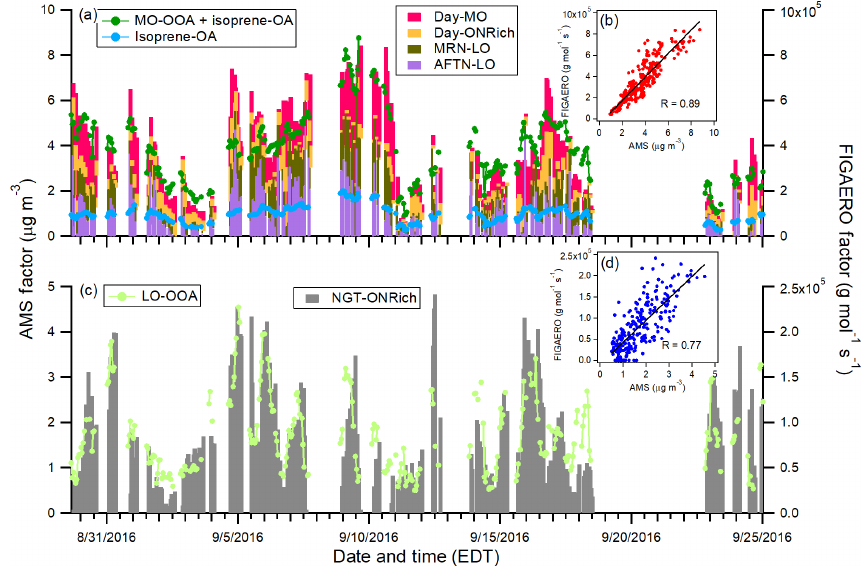
Figure 7. Comparison between AMS daytime factors and FIGAERO-CIMS daytime factors (a, b) , as well as the AMS nighttime factor and FIGAERO-CIMS nighttime factor (c, d)